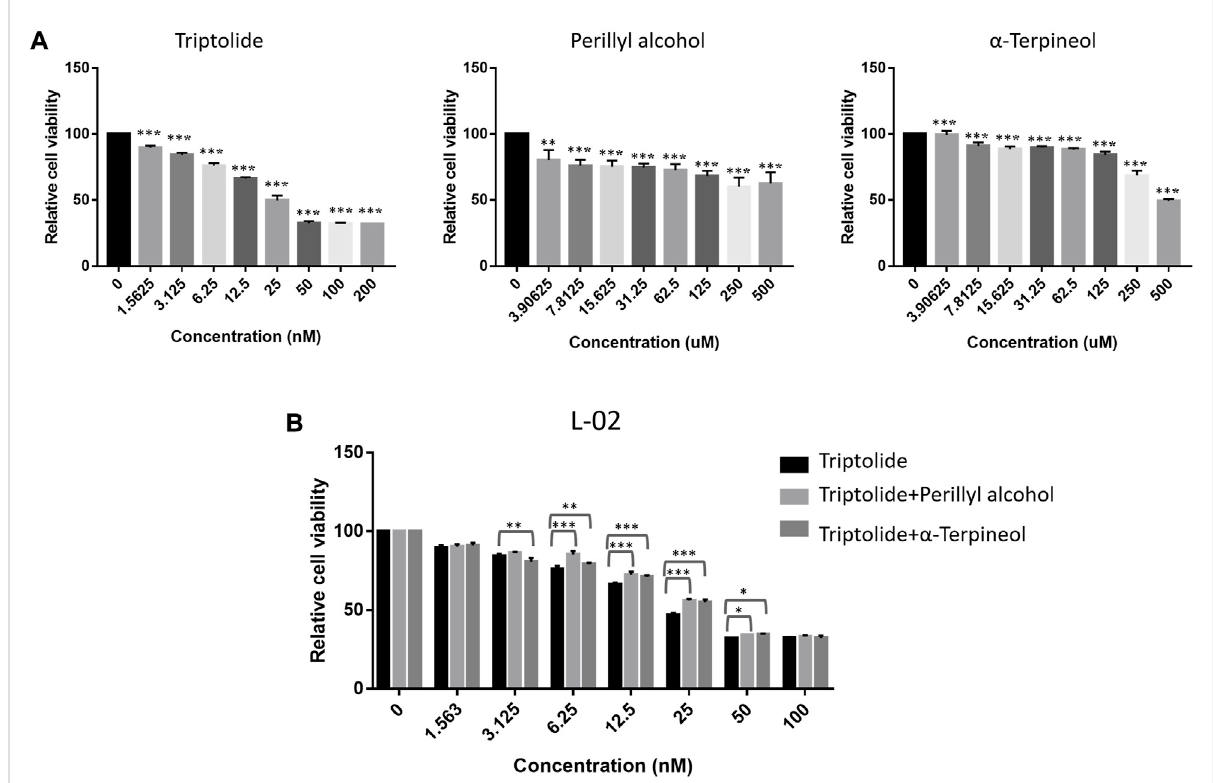
FIGURE 11 Attenuation Experimental Validation In Vitro . The cell proliferation ability of the human hepatocyte cell L-02 treated with triptolide, perillyl alcoholand α -terpineolalone (A) ,orthecombinationoftriptolideandperillylalcohol/triptolideand α -terpineolattheratioof1:500 (B) for48 hwere determined by CCK-8 assay. * p < 0.05, ** p < 0.01, *** p <